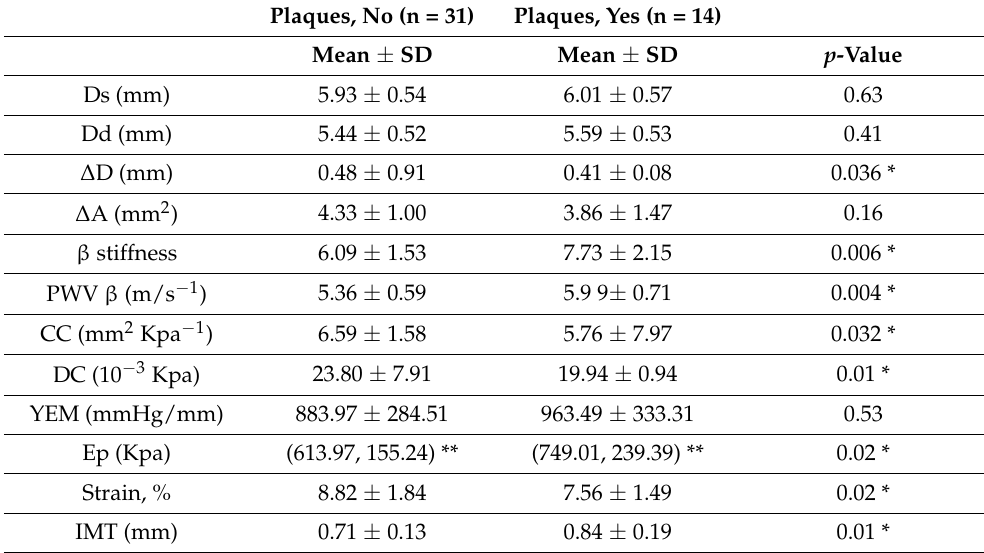
Table 2. Carotid stiffness parameters in subjects with or without carotid plaque.